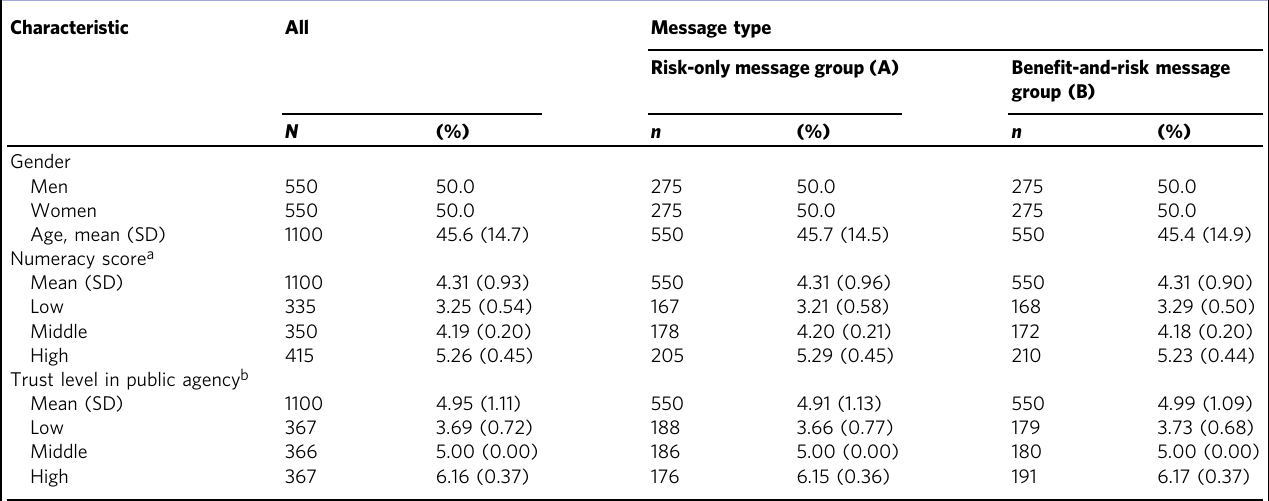
Table 1 Characteristics of the study sample.